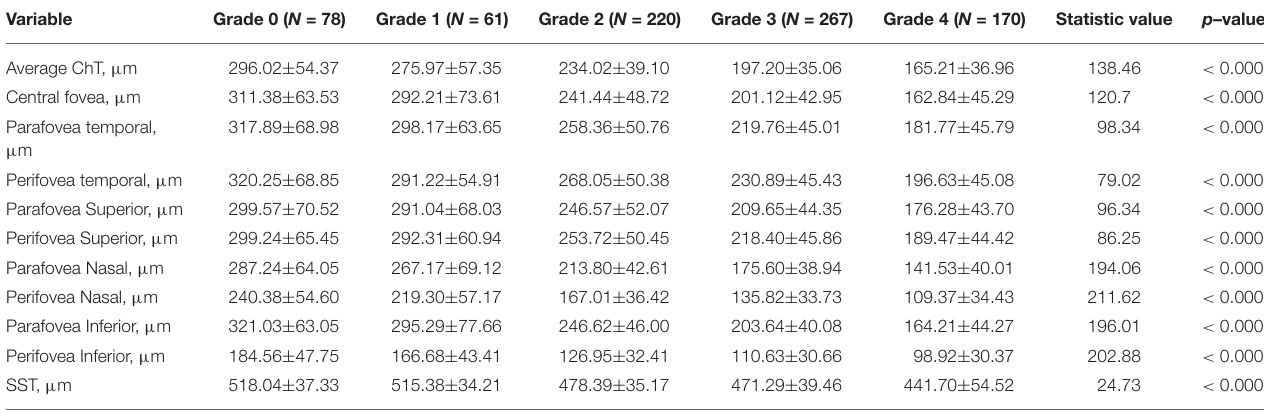
TABLE 4 | Topographical characteristics of choroidal and scleral thickness in tessellated fundus range from Grade 0 to Grade 4.